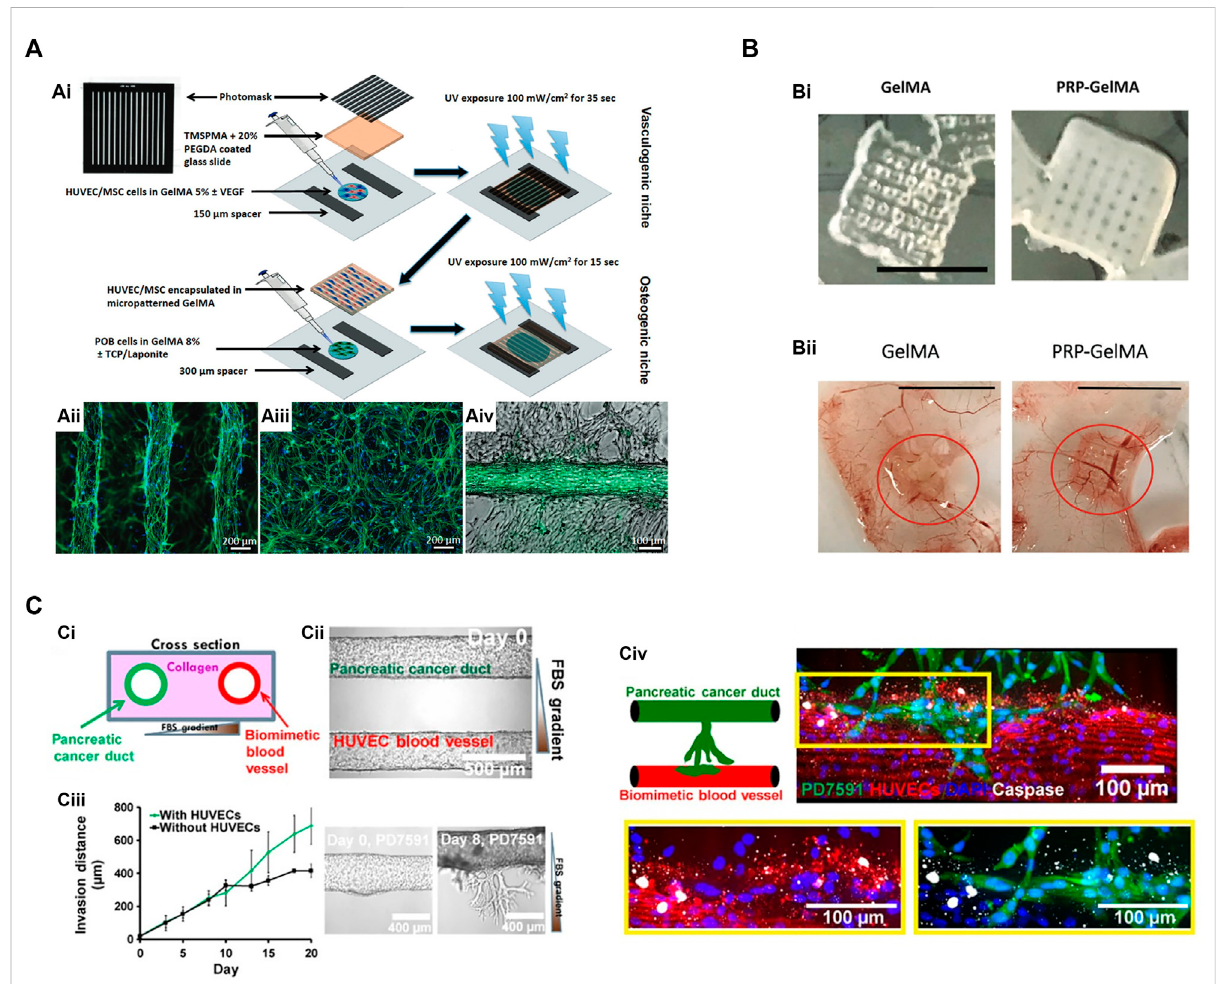
FIGURE 3 Microfabrication techniques utilize GelMA hydrogels for vascular network bioengineering. (A) Construction of 3D vascularized bone tissues by thephotolithographytechnique. (Ai) Schematicofcell-ladenmicropatternedvascularnetworksandosteogenicnicheusingdirectpolymerizationof GelMAhydrogelsthroughphotomasks(Kazemzadeh-Narbatetal.,2017). (Aii) MicropatternedGelMAhydrogelcontainingHUVECs/MSCsstainedfor actin fi laments (green) and DAPI (blue). (Aiii) The same cells encapsulated in unpatterned GelMA hydrogel. (Aiv) Micropatterned HUVECs/MSCs forming a vascular tube surrounded by osteogenic preosteoblasts (POBs) in GelMA hydrogels. (B) 3D printed GelMA scaffolds incorporated with platelet-rich plasma (PRP) to enhance angiogenesis and prevent wound fi brosis (Ibanez et al., 2022). (Bi) Macroscopic appearance of 3D printed GelMA scaffolds with or without PRP. Scale bar = 5 mm. (Bii) The angiogenic properties of GelMA and PRP-GelMA scaffolds were determined by a chick chorioallantoic membrane (CAM) angiogenesis assay. PRP-GelMA scaffolds presented signi fi cantly enhanced vascularization with more recruited CAM vessels. (C) Micro fl uidic vasculature-on-a chip to study the endothelial ablation induced by aggressive pancreatic ductal adenocarcinoma (PDAC) (Nguyen et al., 2019). (Ci) Schematic of PDAC-on-a-chip. (Cii) The micro fl uidic device was composed of two hollow channels embedded within 3D hydrogel. One channel was seeded with endothelial cells to form a biomimetic blood vessel. The other channel was seeded with pancreatic cancer cells to form a pancreatic cancer duct. (Ciii) Upon cultivation, the pancreatic cancer cells began to proliferate and invade into the matrix toward the endothelial lumen. The presence of endothelial cells increased the invasion of cancer cells. (Civ) Cancer cell invasionresultedinendothelialapoptosis(markedbycleavedcaspase-3staining).Endothelialcellswerestainedwithanti-CD31antibody(inred),and pancreatic cancer cells were stained with anti-GFP antibody (in